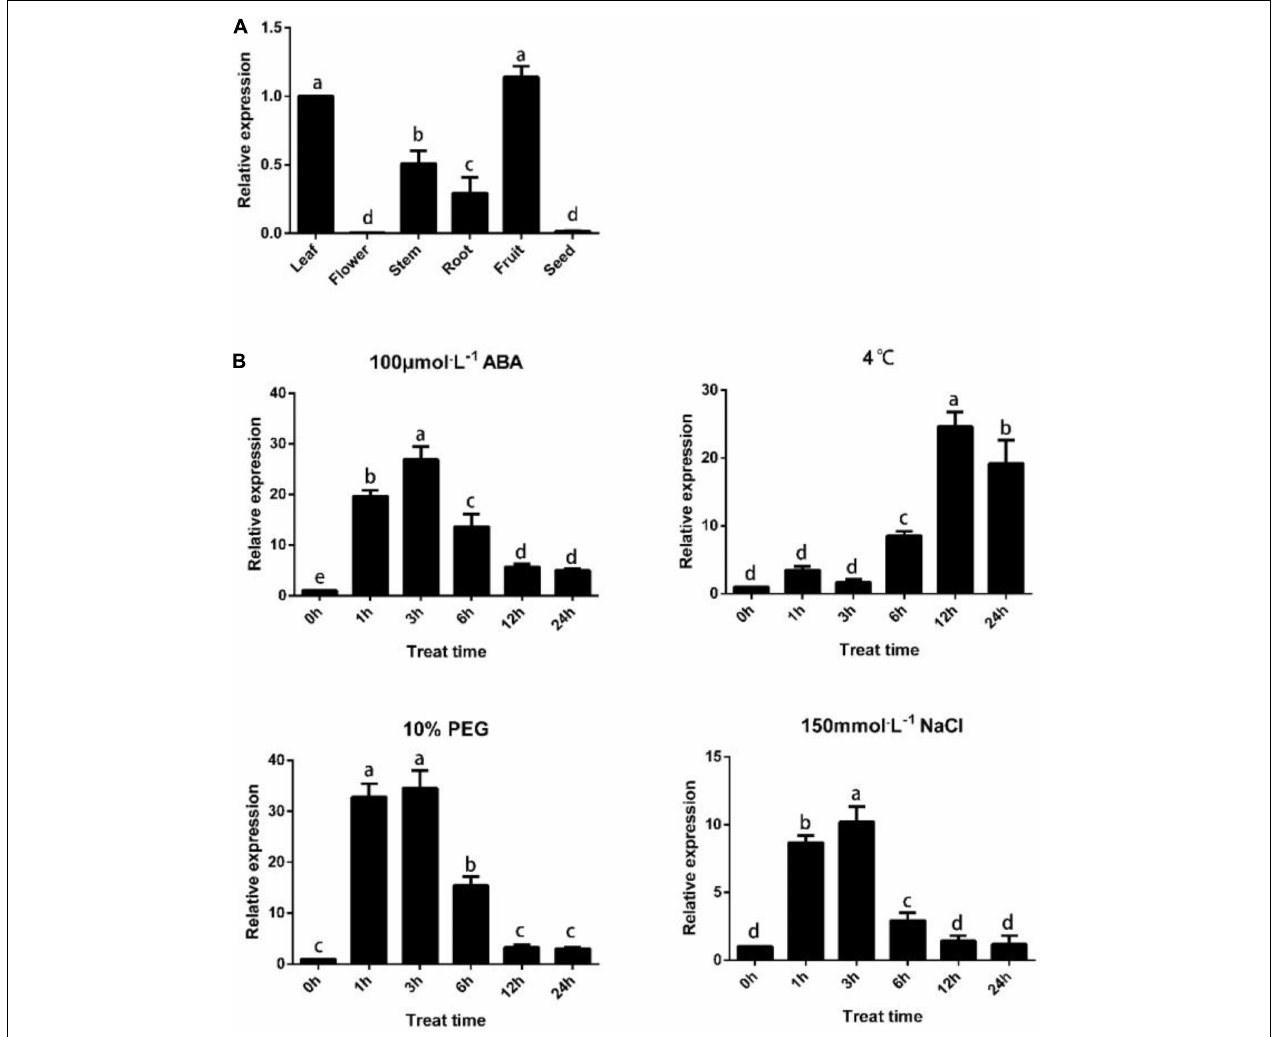
FIGURE 1 | PpTPS1 tissue specificity analysis and expression pattern analysis under abiotic stress. (A) PpTPS1 tissue specificity analysis. (B) Annual peach leaves treated with 100 µ M ABA, 4 ◦ C, 10% PEG and 150 mM NaCl for 0, 1, 3, 6, 12, and 24 h were used as samples to analyze the expression of the PpTPS1 model. Biological triplicates were performed for each sample. Different letters represent significant differences according to ANOVA and Duncan’s test ( P <